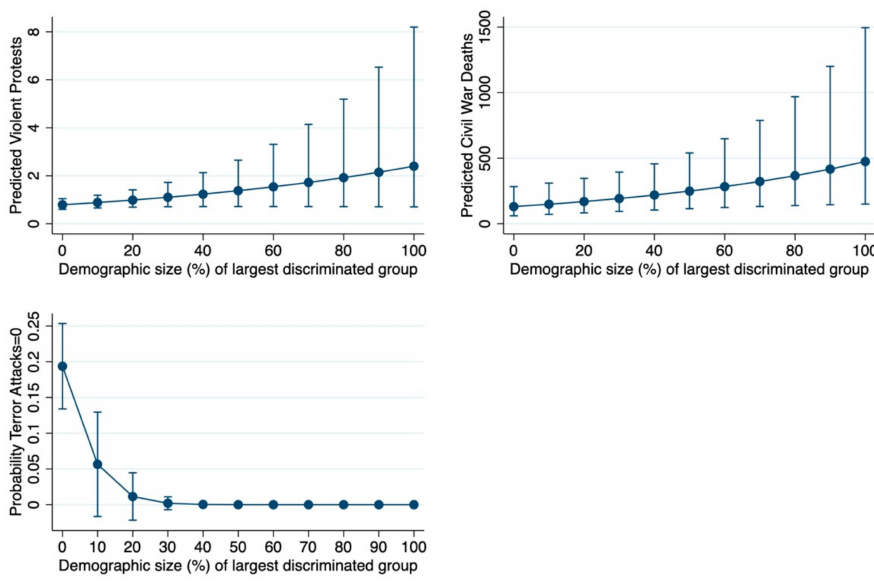
Figure 4. Discrimination and conflict 95%